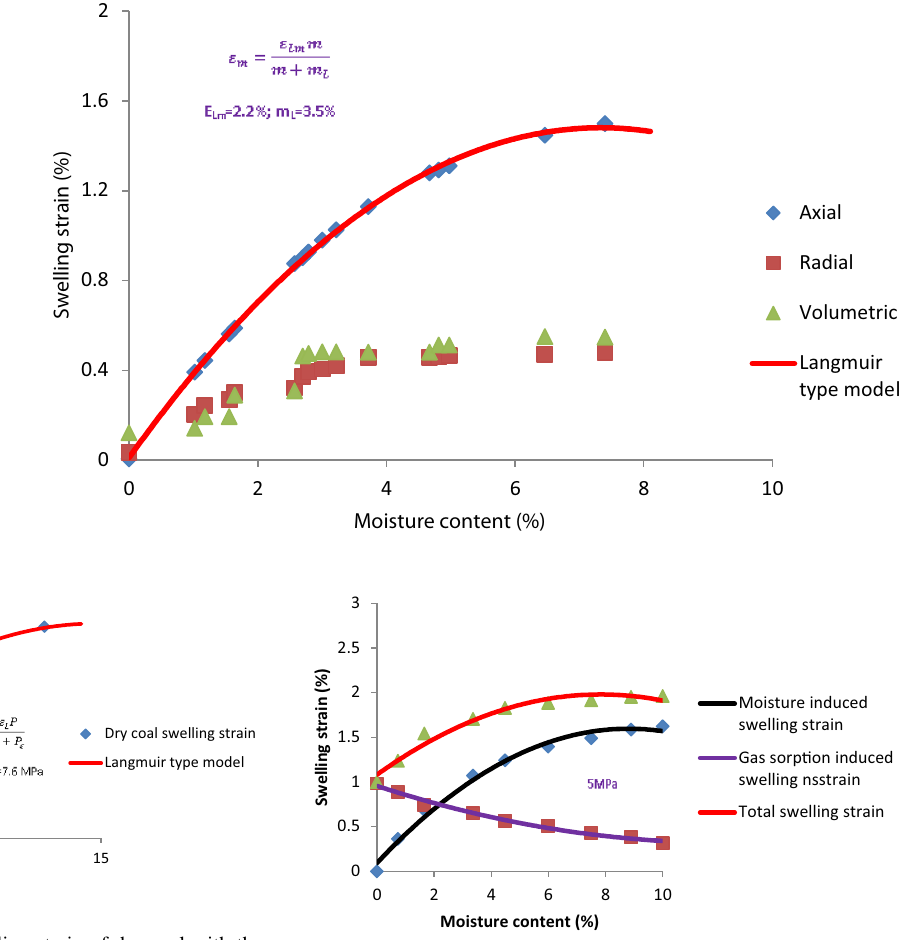
Influence of moisture content on coal swelling strain at 5